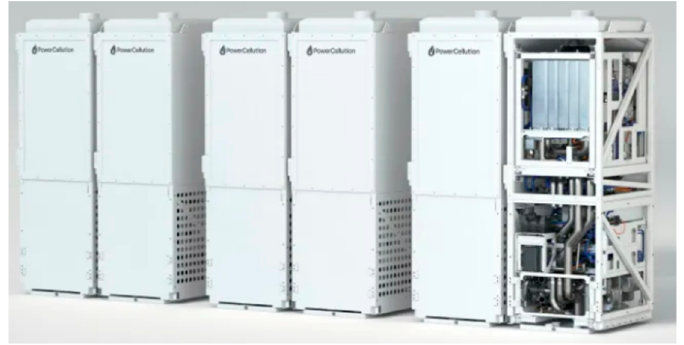
Figure 37. The 200 kW fuel cell system “Power Cellution Marine System 200” [167].